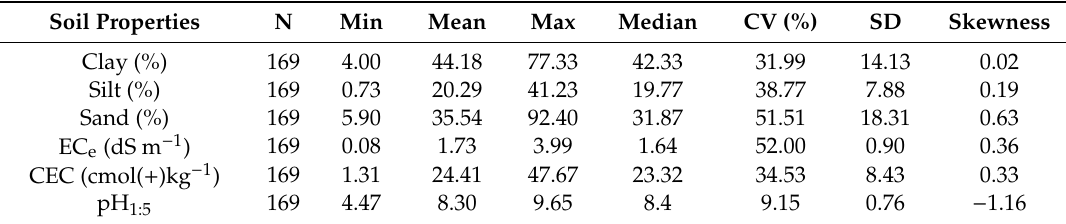
Table 2. Summary statistics of measured soil properties. Note: soil salinity of the saturated soil paste extract (EC e —dS m − 1 ) estimated from the measured electrical conductivity from a 1-part soil to 5-parts water extract (EC 1:5 ), cation exchange capacity (CEC—cmol( + ) kg − 1 ) and pH of a 1-part soil to 5-parts water extract (pH 1:5 ).